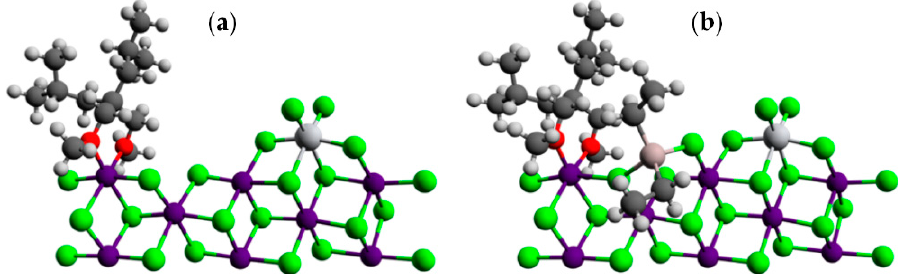
Figure 9. ( a ) DFT model of adjacent TiCl 4 and 2,2-diisobutyl-1,3-dimethoxypropane co-adsorption on a MgCl 2 (110) edge; ( b ) same as panel a after the adsorption of an AlEt 2 Cl molecule. Reprinted with permission from [116]. Copyright (2017) American Chemical Society.